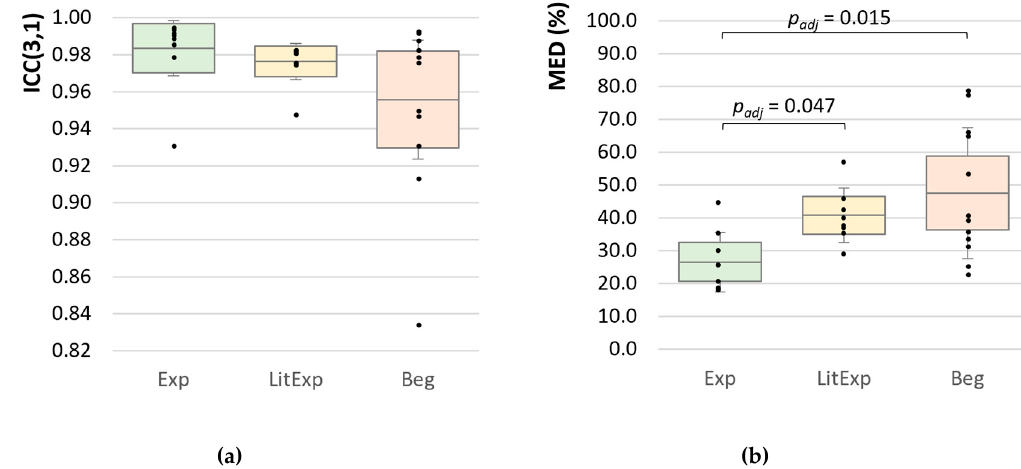
Figure 8. Comparisons of force parameters between the groups. Displayed are the Ms, SDs (error bars) and 95%-CIs of ( a ) the starting force (F start (N)), ( b ) the maximum force (F max (N)) and ( c ) the ratio of F start to F max (%) of the 10 trials in the groups experienced (Exp; green), little experienced (LitExp; yellow) and beginners (Beg; orange). The significant results are displayed by adjusted p -values.